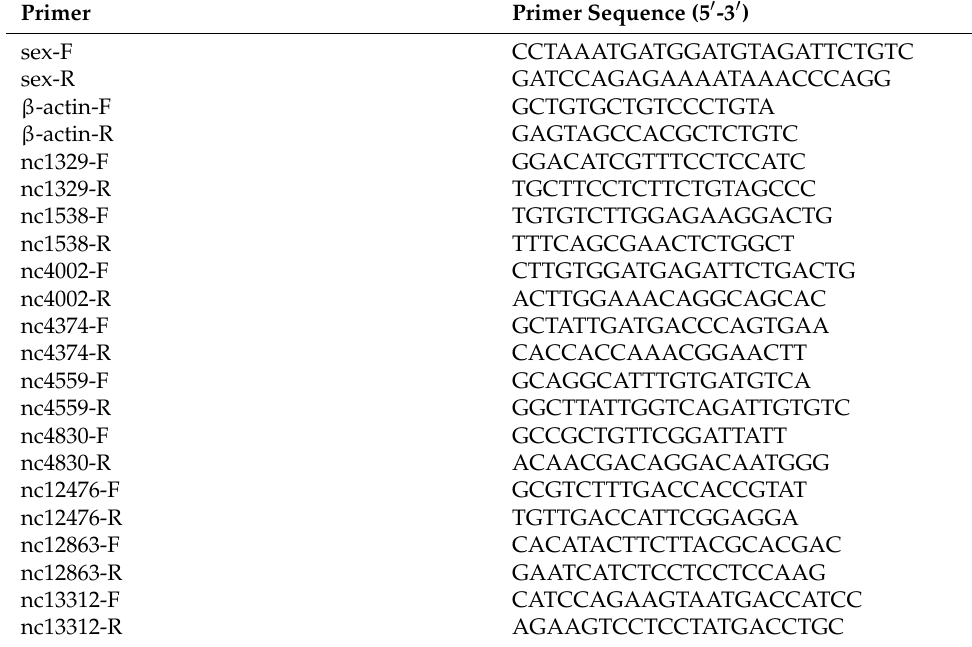
Table 1. Primer sequences in this